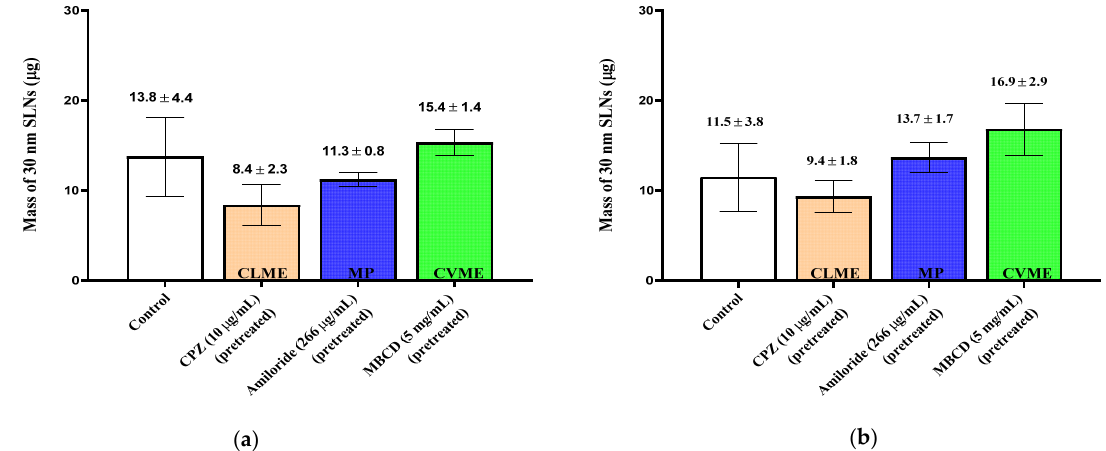
Figure 5. Uptake (30 min) of 30 nm SLNs in the nasal olfactory ( a ) and respiratory ( b ) tissues pre-treated with endocytic inhibitors. Bar graphs display mean nanoparticle uptake ± standard deviation determined from the recovery of Nile Red from the tissues. Statistical comparisons were made between each of the inhibited tissues and control tissues using Student’s two-tailed t -test ( p < 0.05). No statistically significant differences were found.